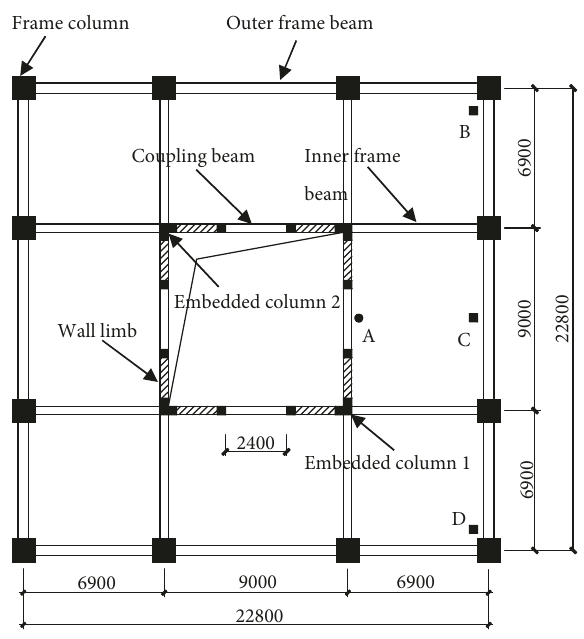
Figure 1: Structure layout.